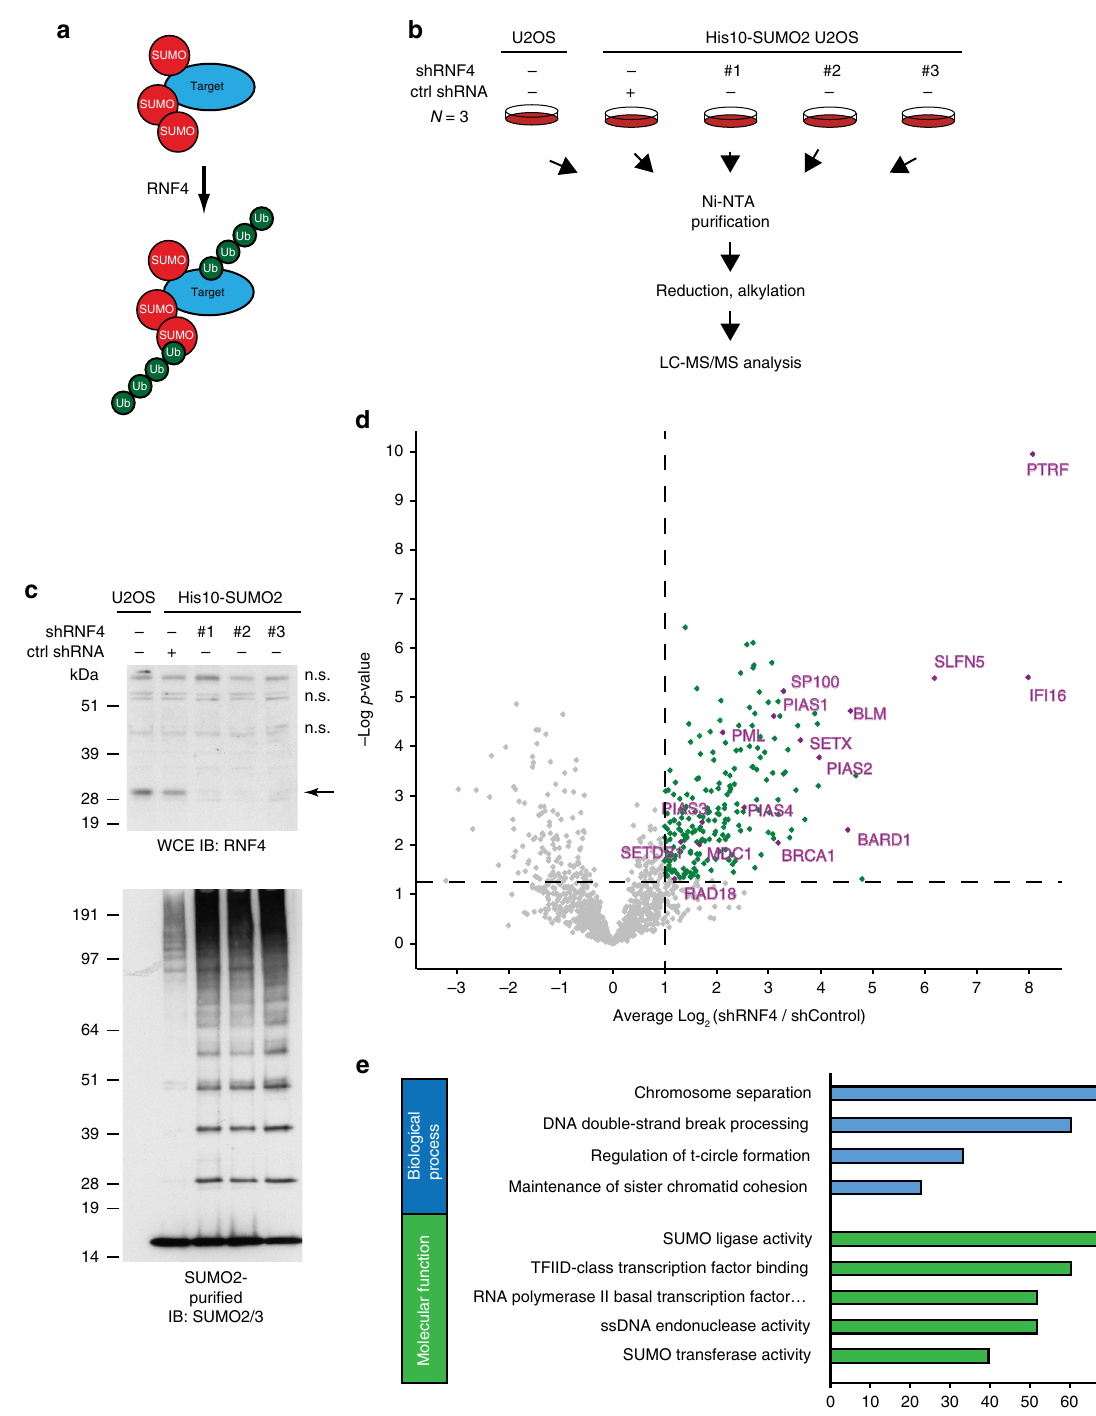
Fig. 1 SUMO2 substrates regulated by the SUMO-targeted ubiquitin ligase (STUbL) RNF4. a The STUbL RNF4 binds and ubiquitylates SUMOylated substrates. b Experimental approach. c U2OS cells stably expressing His10-SUMO2 were separately infected with lentiviruses expressing three different shRNAs directed against RNF4 or a control shRNA. Three days post infection, the cells were harvested, lysed in a denaturing buffer, and His10-SUMO2 conjugates were puri fi ed. RNF4-knockdown ef fi ciency and the puri fi cation ef fi ciency of His10-SUMO2 conjugates were veri fi ed by immunoblotting. Three biological replicates were performed and the puri fi ed proteins were identi fi ed by mass spectrometry. n.s. indicates non-speci fi c bands. d Volcano plot showing RNF4-regulated SUMO2-target proteins. Each dot represents an identi fi ed protein. The green dots represent proteins increased for SUMOylation in response to RNF4-knockdown with an average log2 ratio > 1 when this increase is statistically signi fi cant with a -log10 of the p -value higher than 1.3. This corresponds to a two-fold increase with a p -value lower than 0.05 for statistical signi fi cance. Selected proteins are highlighted in purple. e Gene ontology analysis of all SUMO enriched proteins after RNF4-knockdown from d regarding biological process and molecular function. Full Gene ontology is shown in Supplementary Data 2. Unprocessed full-size scans of blots are provided in Supplementary Fig.